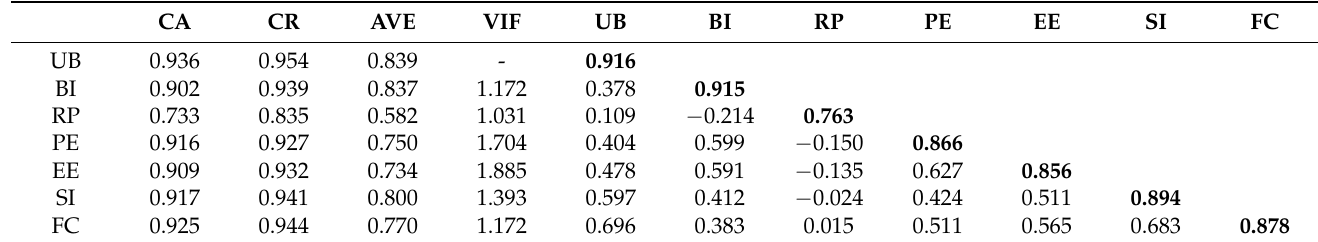
Table 3. Construct correlation matrix and reliability